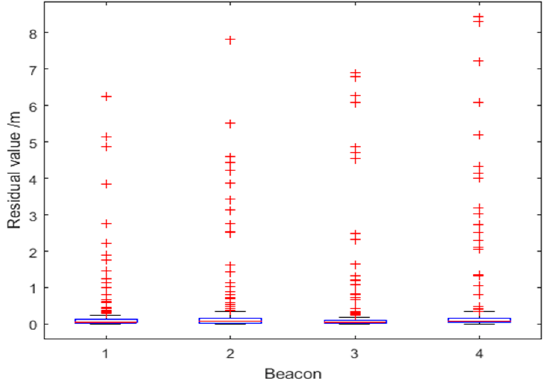
Figure 19. Distributions of residual value for the four Beacons for Route 2.